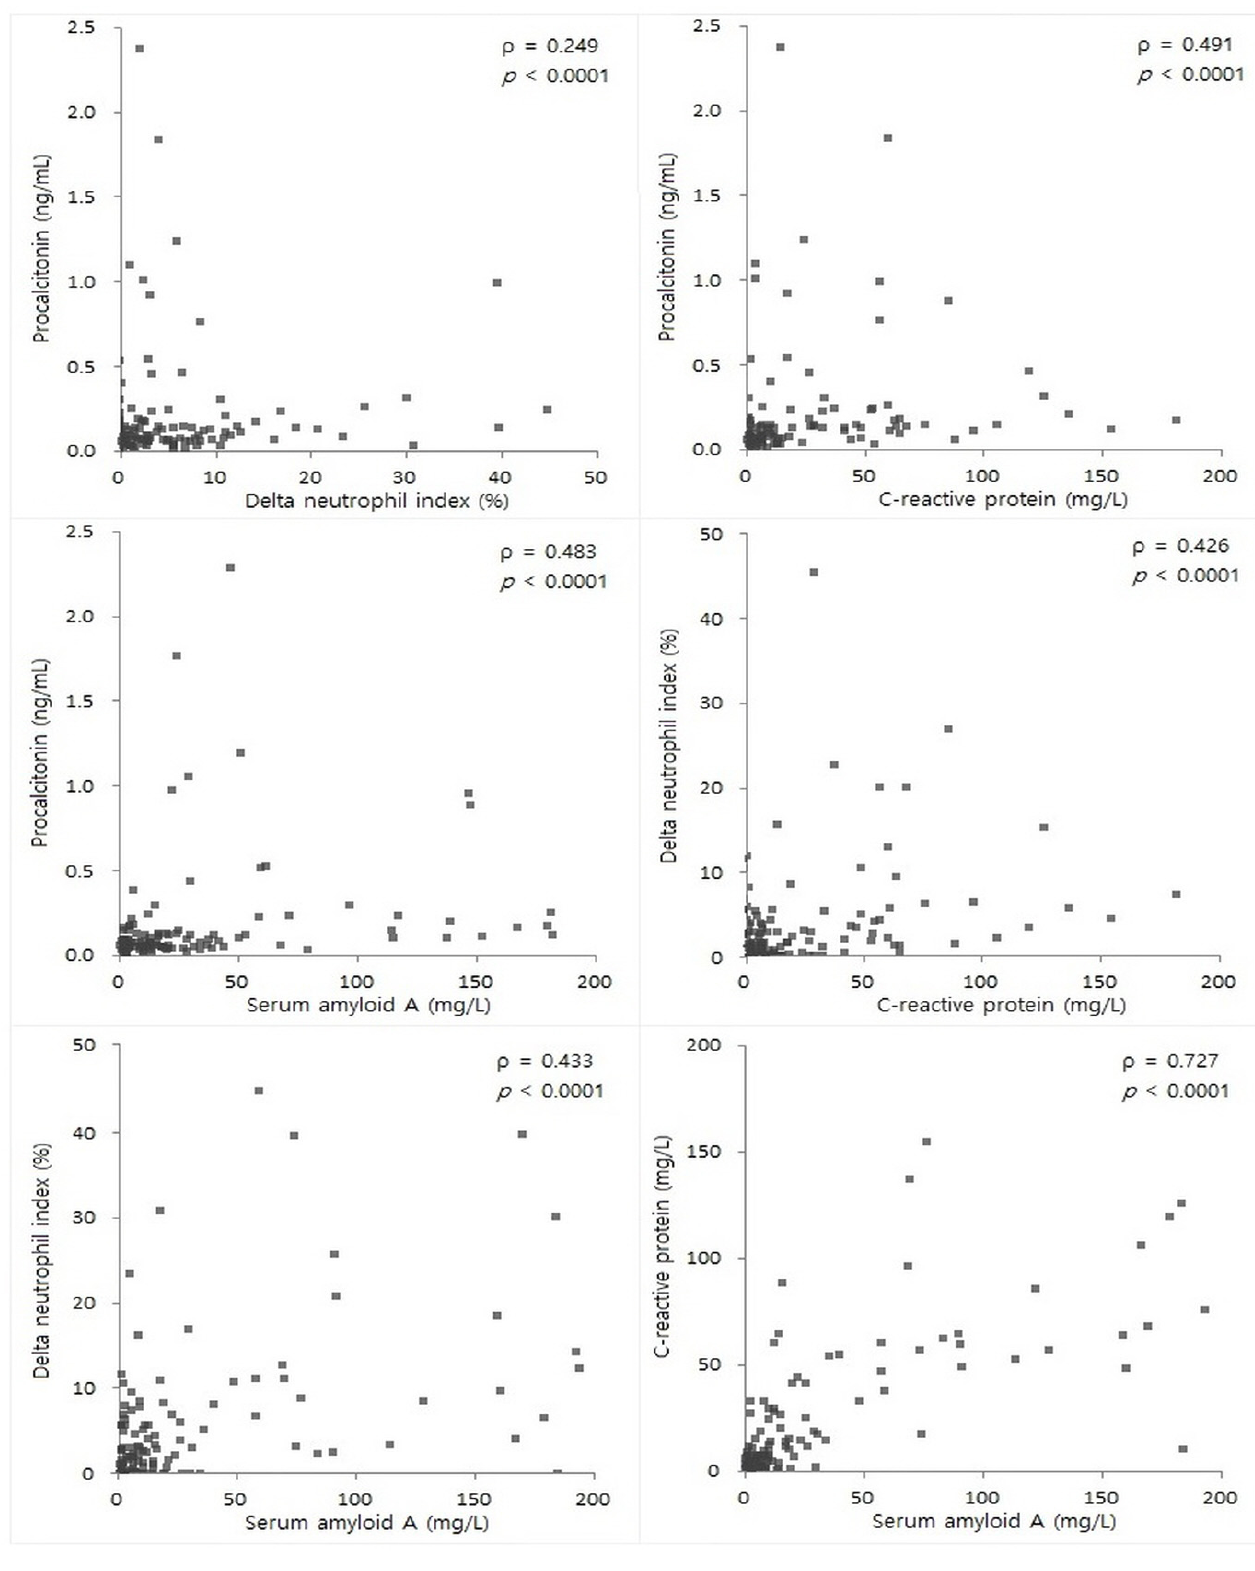
Figure 2. Correlations between the levels of each pair of examined markers among procalcitonin, delta neutrophil index, C-reactive protein, and serum amyloid A.